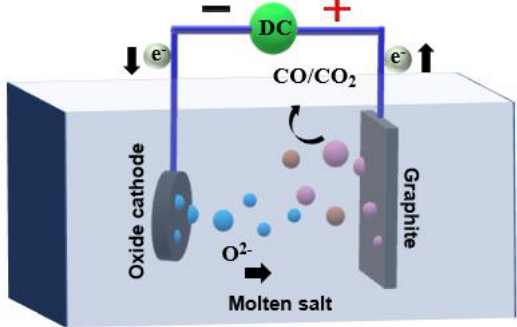
Figure 13. Electrolysis mechanism diagram.